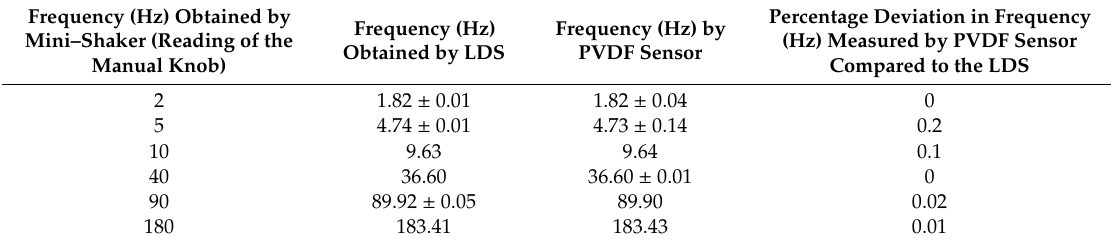
Figure 7. Voltage output from the sensor plotted against the tip displacement of the cantilever on the same scale for a frequency of 90 Hz: ( a ) Voltage output from the sensor against the tip displacement for a total testing duration of 30 s where the mini shaker is on between 5 and 25 s; ( b ) A zoomed in version of the voltage and tip displacement plot which shows the waveforms of the strain input and the corresponding voltage output of the sensor. Table 2. Comparison between frequency measured by the mini shaker, LDS and the developed PVDF